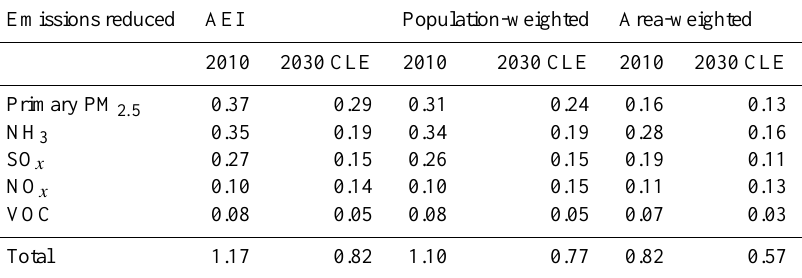
Table 1. EMEP4UK-modelled estimates of the impact of 30% UK terrestrial emissions reductions on three measures of UK-average surface concentrations of PM 2 . 5 (µgm − 3 ) : (i) the average of the model grids containing the 45 monitors used to calculate the UK PM 2 . 5 average exposure indicator (AEI), (ii) the population-weighted average, and (iii) the area-weighted (i.e. geographical) average, for 2010, and for 2030 under a CLE emission scenario (using 2010 meteorology). For context, the modelled reductions in the baselines between 2010 and 2030 CLE for the three measures of UK-average PM 2 . 5 are 2.42, 2.24, and 1.70µgm − 3 , respectively. Emissions reduced AEI Population-weighted